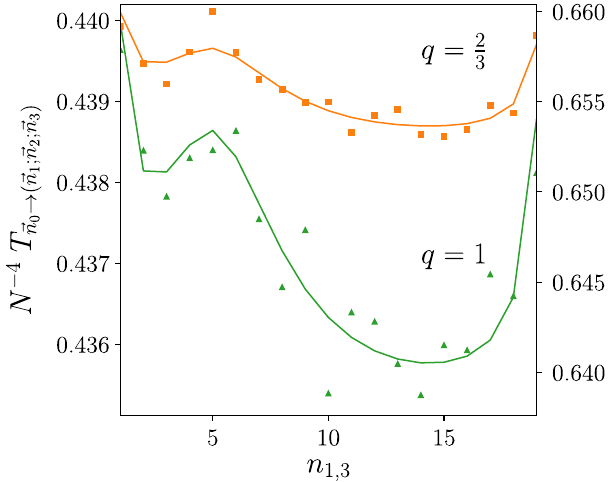
FIG. 7. Mean first-passage time in a 4D domain with reflecting 21 , with i ¼ 1 , 2, 3, 4, to either of three boundaries of size N i ¼ targets as a function of the n 1 coordinate. The walker initial ; 1 position is at ⃗ n 0 ¼ ð 5 ; 4 ; 2 ; 1 Þ . The coordinates of the first target ≤ 20 , while the second and ; 8 ; 9 ; 9 Þ , with 2 ≤ n 1 are ⃗ n 1 ¼ ð n 1 ; 1 ; 1 third targets are fixed at ⃗ n 2 ¼ ð 8 ; 2 ; 1 ; 10 Þ and ⃗ n 3 ¼ ð 6 ; 5 ; 8 ; 7 Þ . The lines are obtained using the MFPT to either of three targets displayed in Eq. (S24) in Ref. [75], with the MFPT between any two lattice sites provided by Eq. (31), while the dots are obtained by averaging 10 6 stochastic